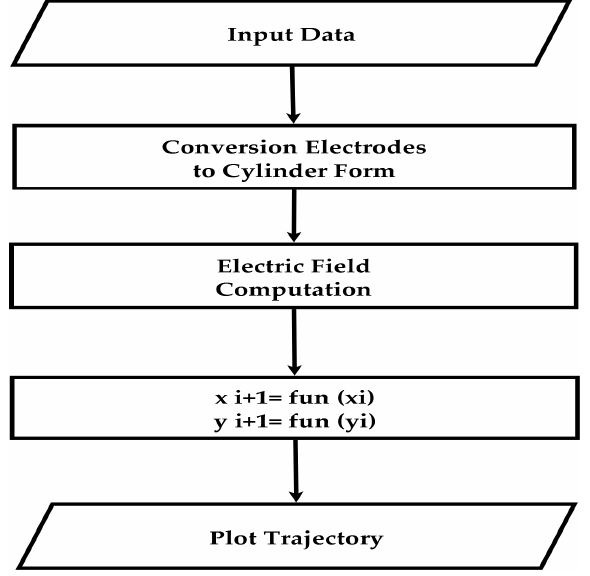
Figure 2. Flow chart of the particle trajectory computation.